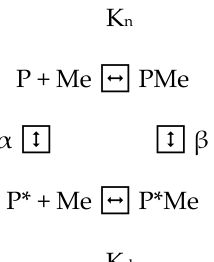
Figure 3. Heat sorption curves for apo-(1 mM EGTA) and Ca 2+ -loaded (1 mM CaCl 2 ) bovine α - lactalbumin derived from differential scanning calorimetry measurements. 10 mM HEPES, pH 8.